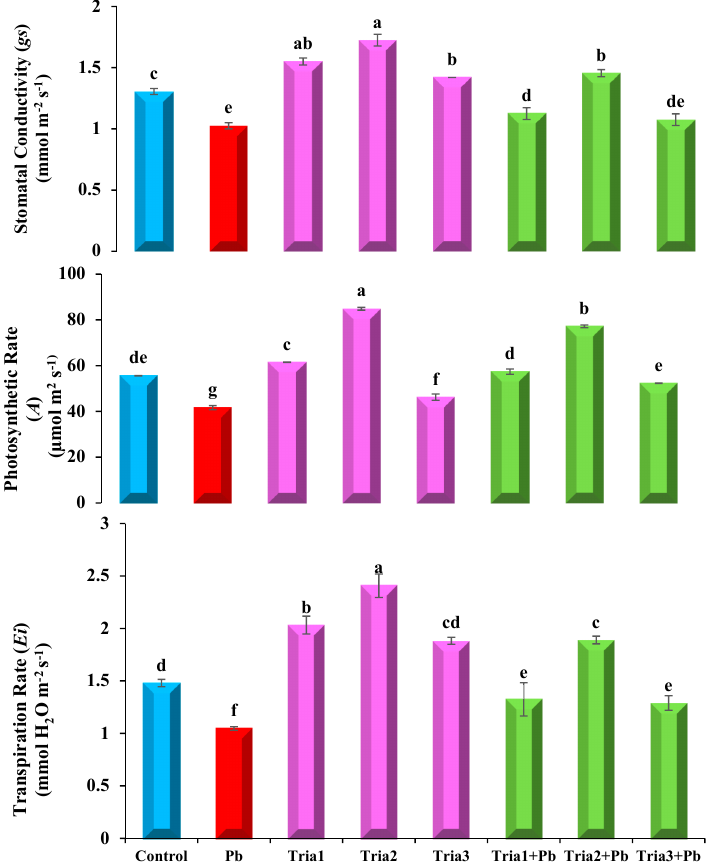
Figure 1. Effect of Tria and Pb on Gas Exchange Attributes of Phaseolus vulgaris L. (Data exhibit means ± SE of 4 replicates. Non-identical letters specify significant difference amid the treatments at p ≤ 0.05. Control, Pb = 400 mg kg − 1 Pb, Tria-1 = 10 µmol L − 1 of Tria, Tria-2 = 20 µmol L − 1 of Tria, Tria-3 = 30 µmol L − 1 of Tria.